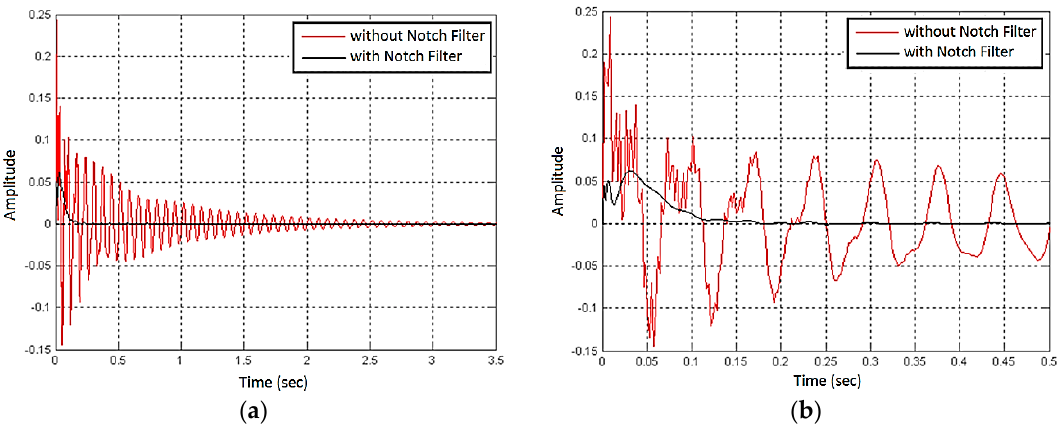
Figure 18. Notch filter control result: ( a ) tracking error of step response; and ( b ) zoomed plot of ( a ).